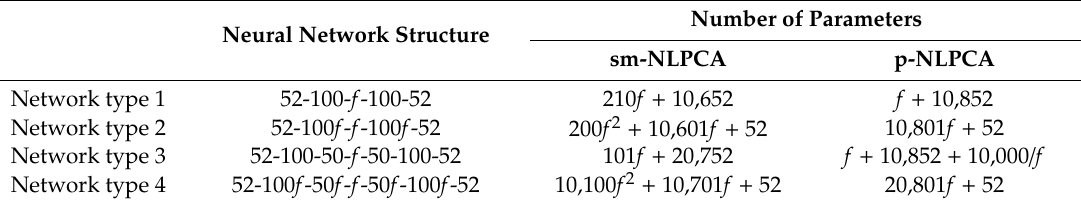
Table 3. Number of parameters for di ff erent neural network types.